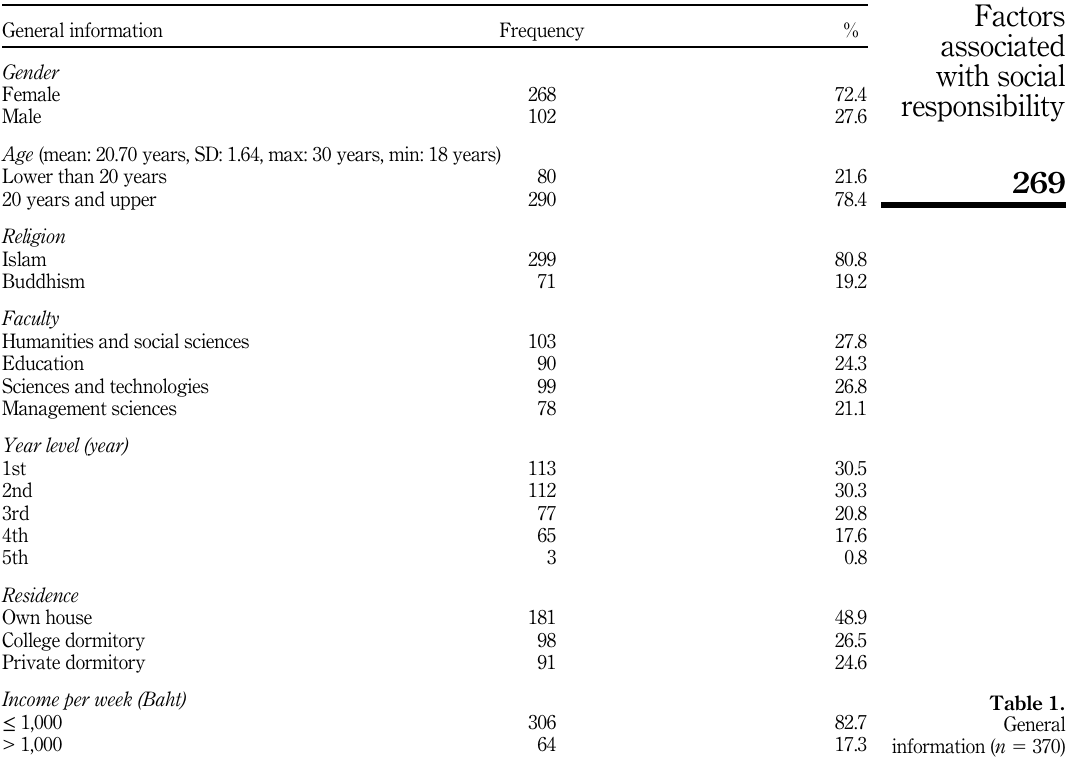
party with their friends when they feel stress because of the COVID-19 pandemic ” (57.8%). About three-fourths of them had a high positive attitude toward the state measures for COVID-19 prevention and control (78.9%), Table 5.